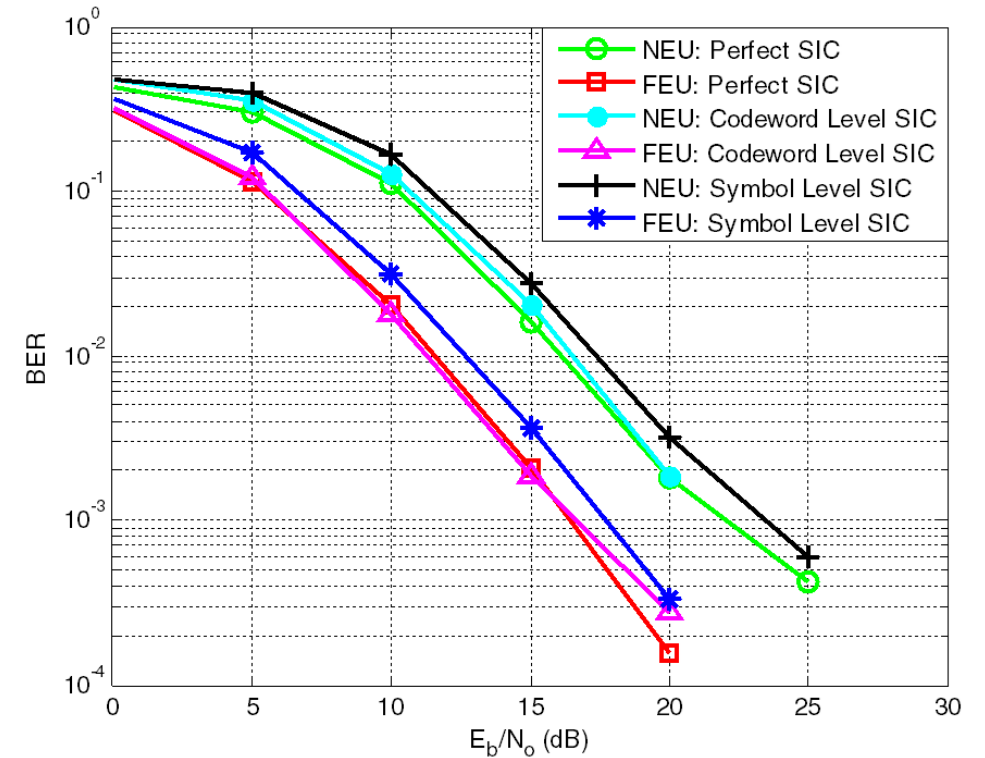
Figure 9. BER performance comparison of different receivers for NEU and FEU with P 1 , P 2 = 0.2,0.8.